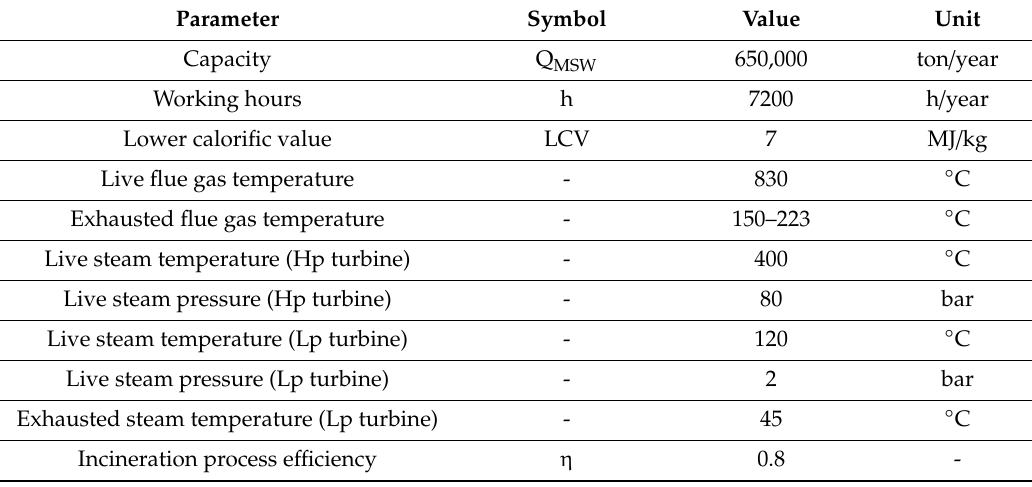
Table 4. Properties of the power